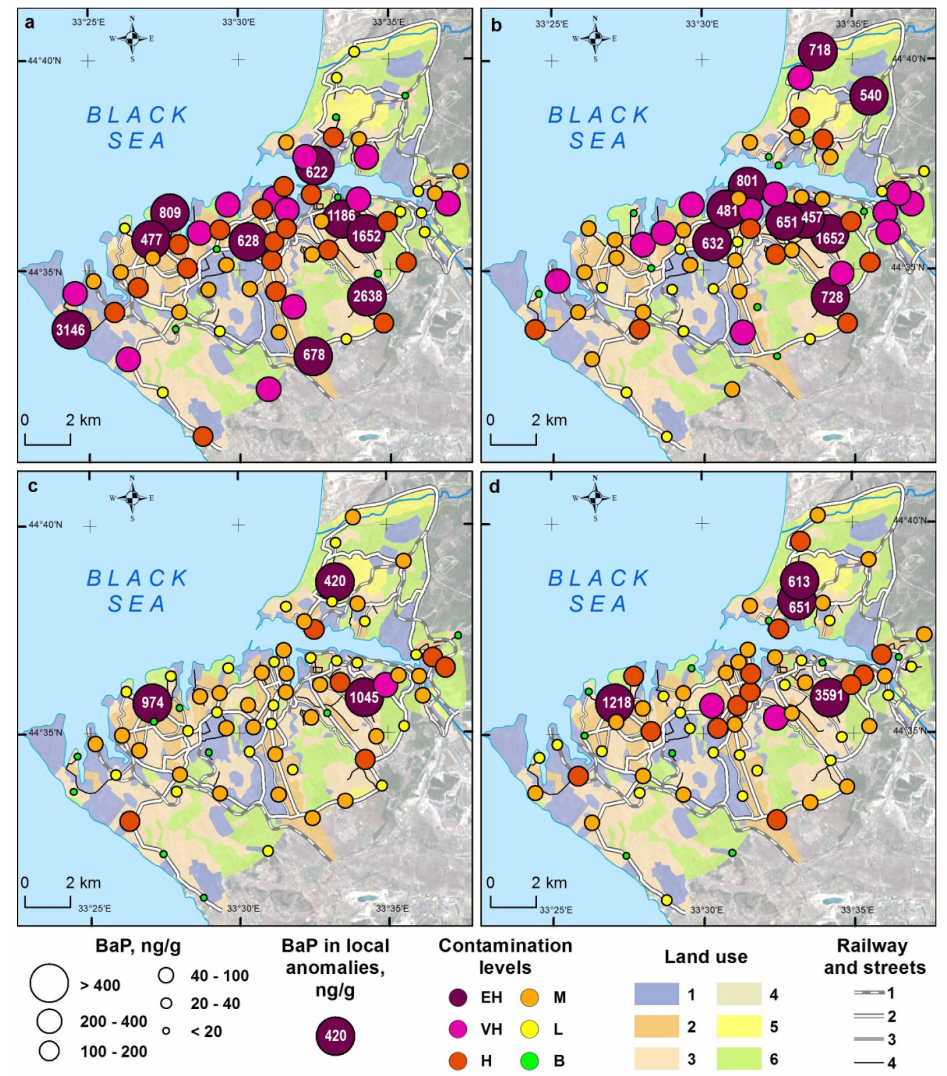
Figure 5. Distribution of BaP in soils ( a ) and their PM 10 particles ( b ), road dust ( c ) and its PM 10 particles ( d ) within the territory of Sebastopol. Contamination levels: EH—extremely high, VH— very high, H—high, M—moderate, L—low, B—background. Land use zones: 1—industrial, 2— multi-storey residential, 3—low-rise residential, 4—residential and recreational, 5—agrogenic, 6— recreational. Railway (1) and streets with: 2—large roads, 3—medium roads, 4—small